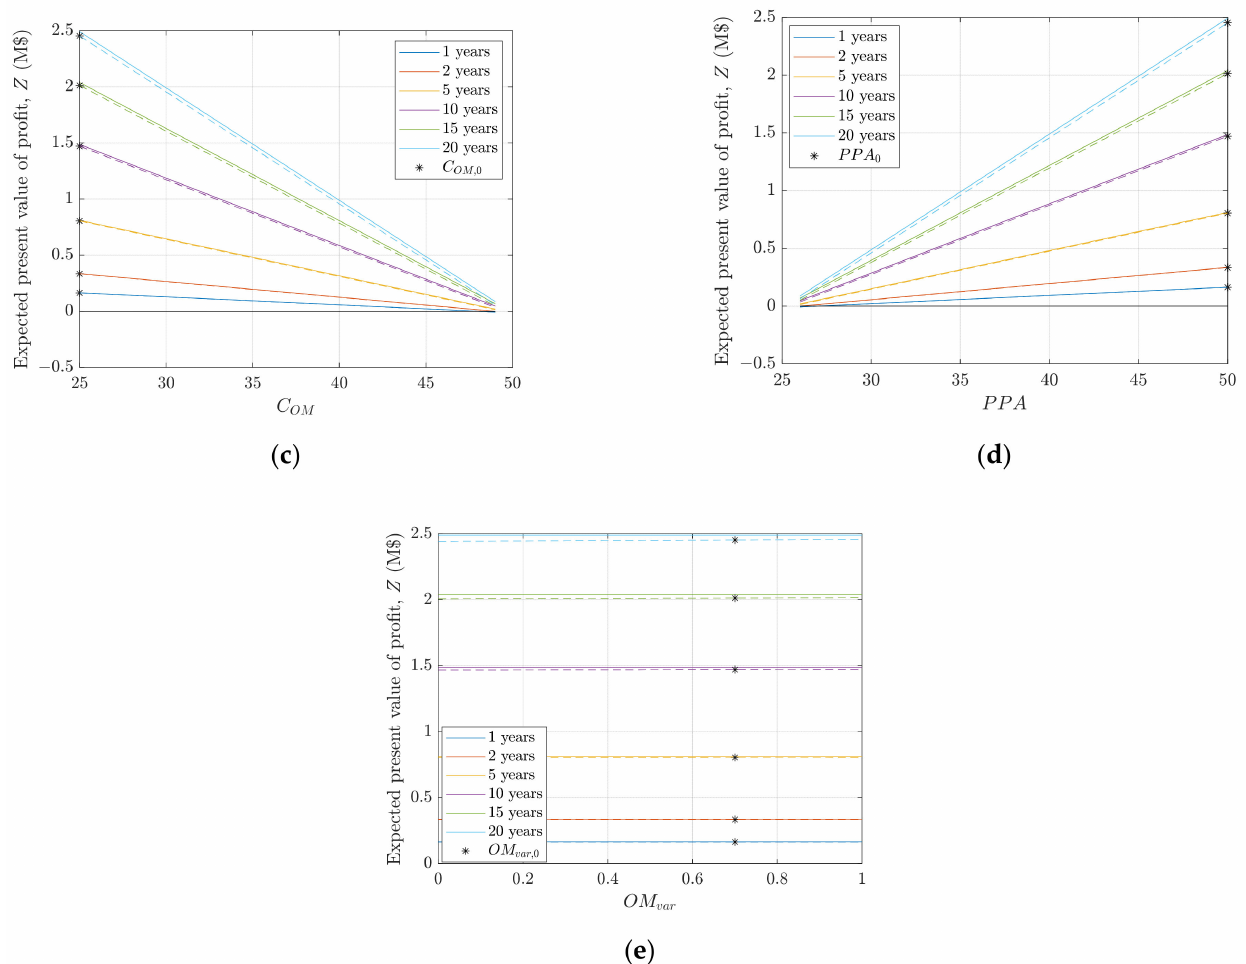
Figure 7. Expected present value of profit Z as a function of: ( a ) life extension costs C ext ; ( b ) failure costs H ; ( c ) annual operation and maintenance costs C OM ; ( d ) power price PPA; ( e ) operation and maintenance costs variable proportion OM var . The stars indicate the base case values. For ( a ), the stars indicate C ext for the four retrofit levels. The solid lines show Z 0 and the dashed lines show Z